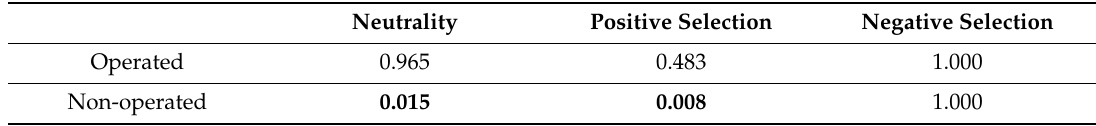
Table 7. Results of the Z selection test